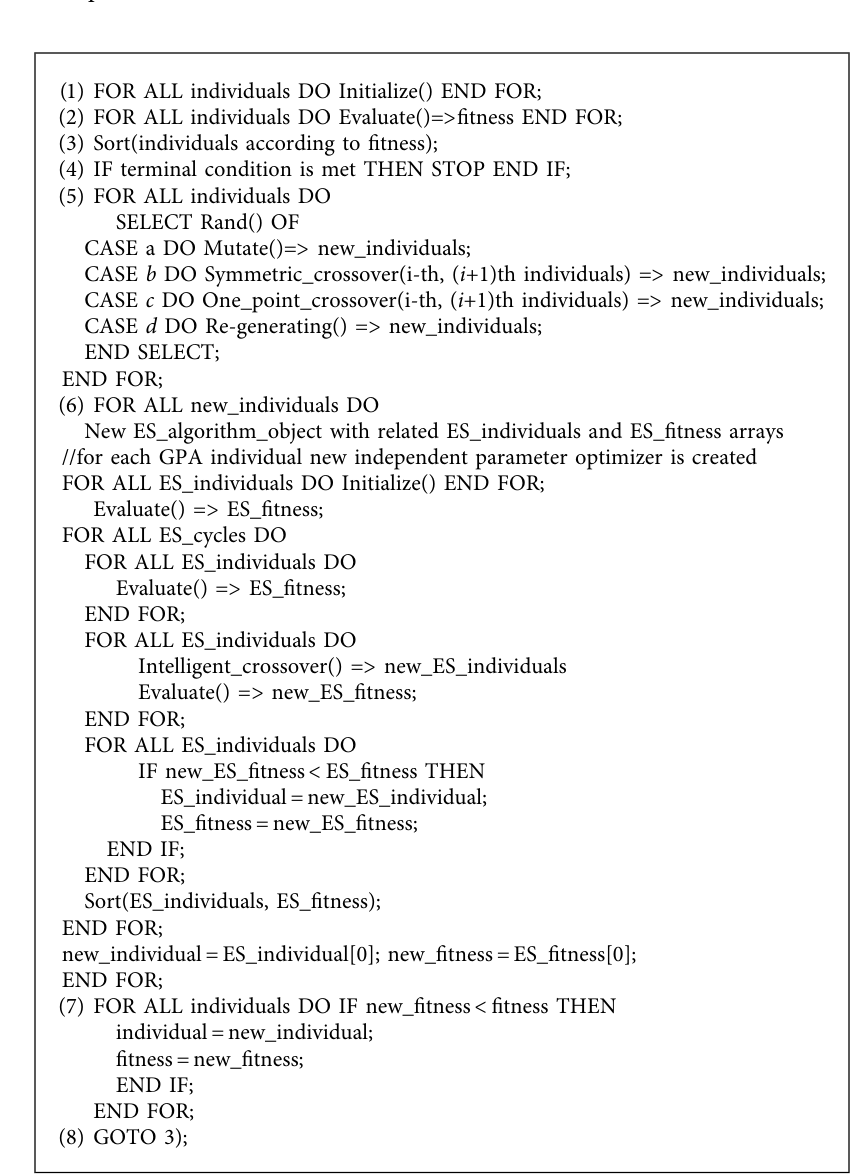
A LGORITHM 1: Used GPA-ES algorithm